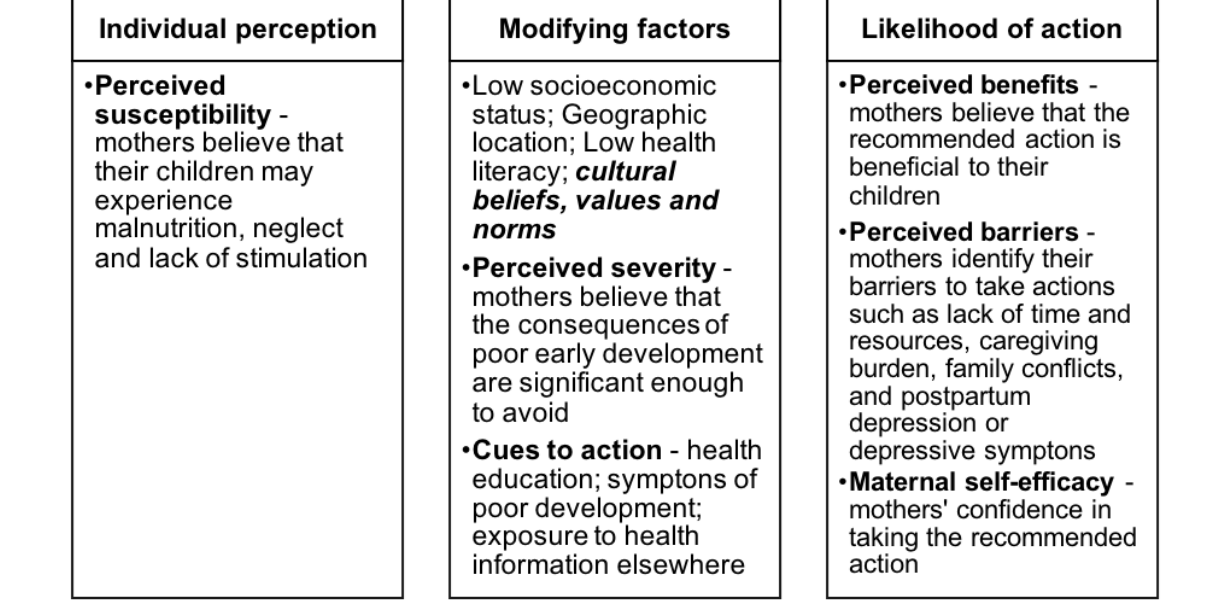
Figure 1. Theoretical framework based on the health belief